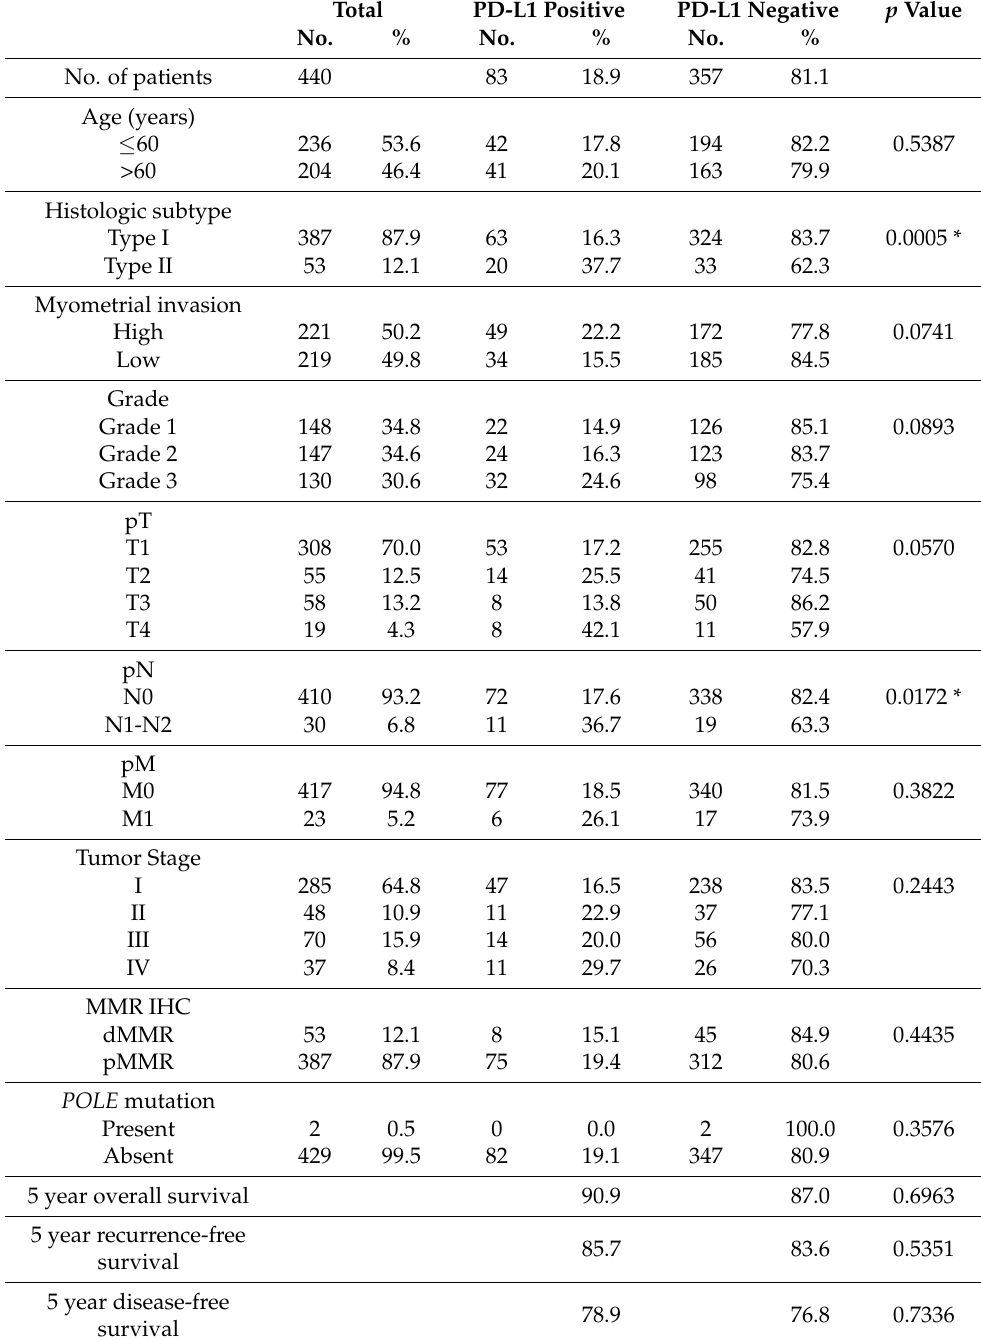
Table 2. Association of PD-L1 protein expression with clinico-pathological characteristics in endome- trial